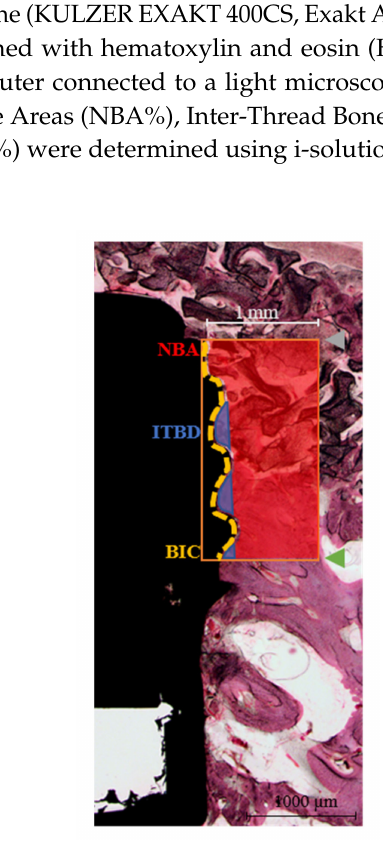
Figure 2. Histomorphometric parameters around the implants for analyzing new bone generation rates. The region of interest (orange rectangle) was set at a width of 1 mm, and height was defined as the distance from the implant platform and to the third thread of the implant fixture. NBA, new bone area; ITBD, inter-thread bone density; BIC, bone-to-implant contact; gray point, implant platform;